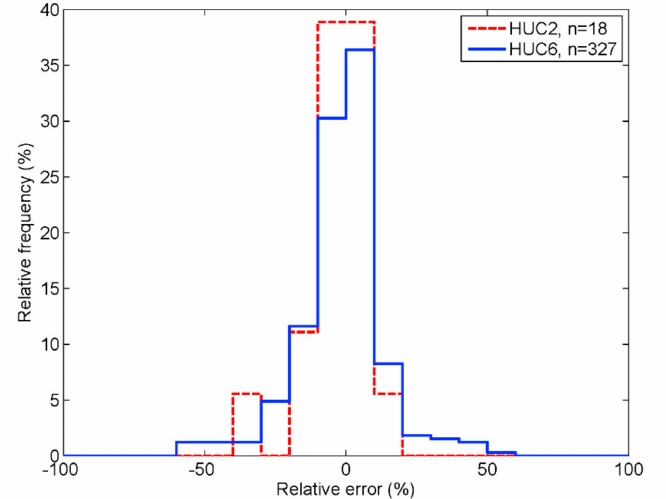
Figure 7. Relative histograms of the relative errors in the long-term mean annual HUC2 and HUC6 precipitation rates.